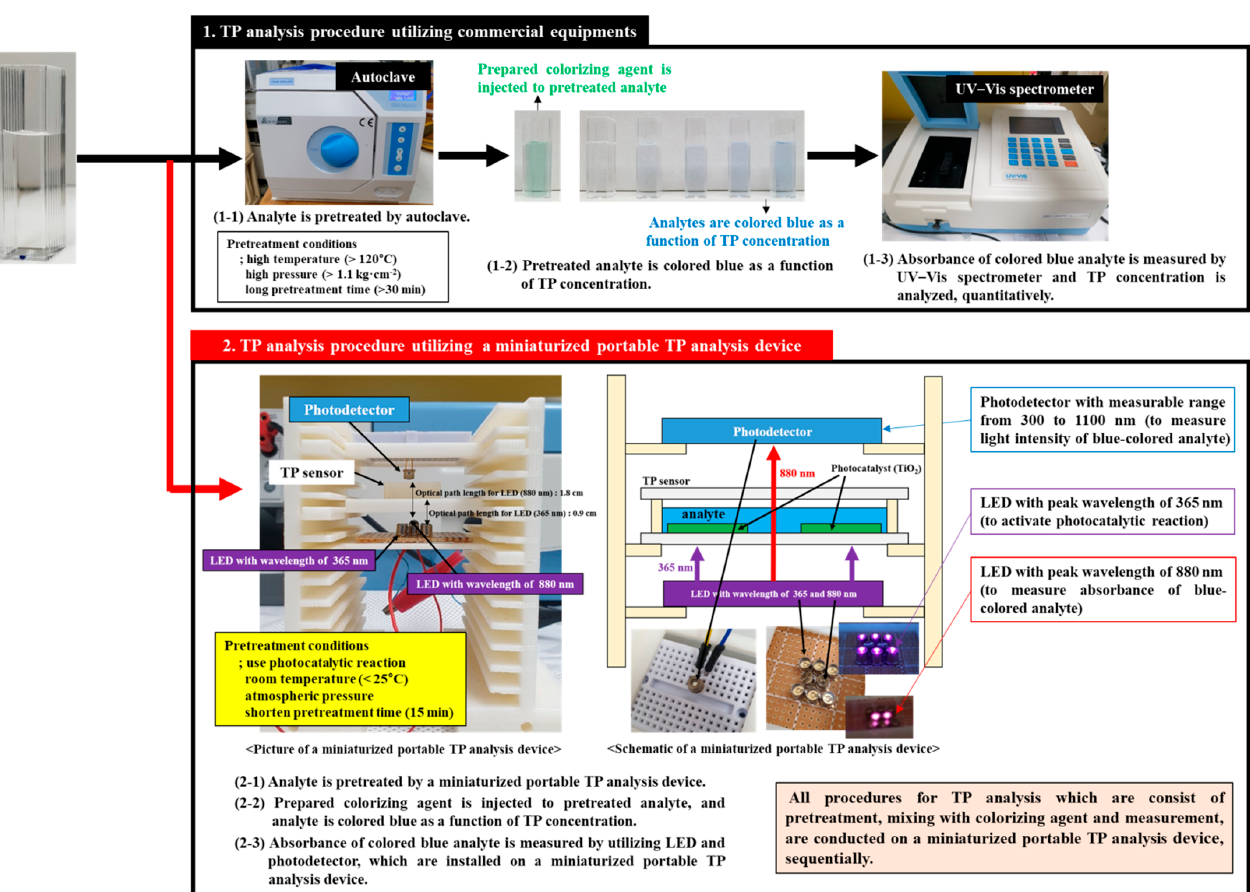
Figure 2. TP analysis procedures utilizing commercial equipment (i.e., autoclave and UV–Vis spectrometer) and the miniaturized portable TP analysis device described in this work.